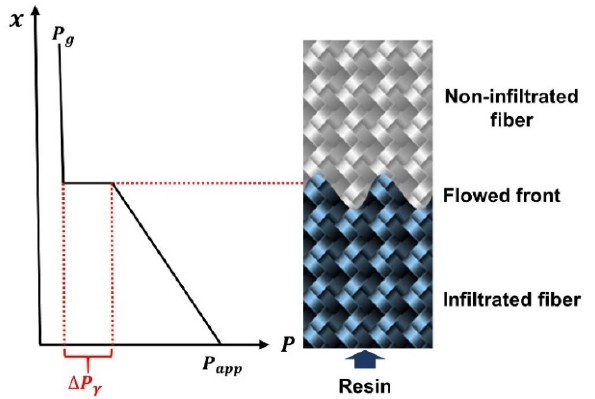
Figure 2. Schematic diagram of resin infiltrated fiber cloth.